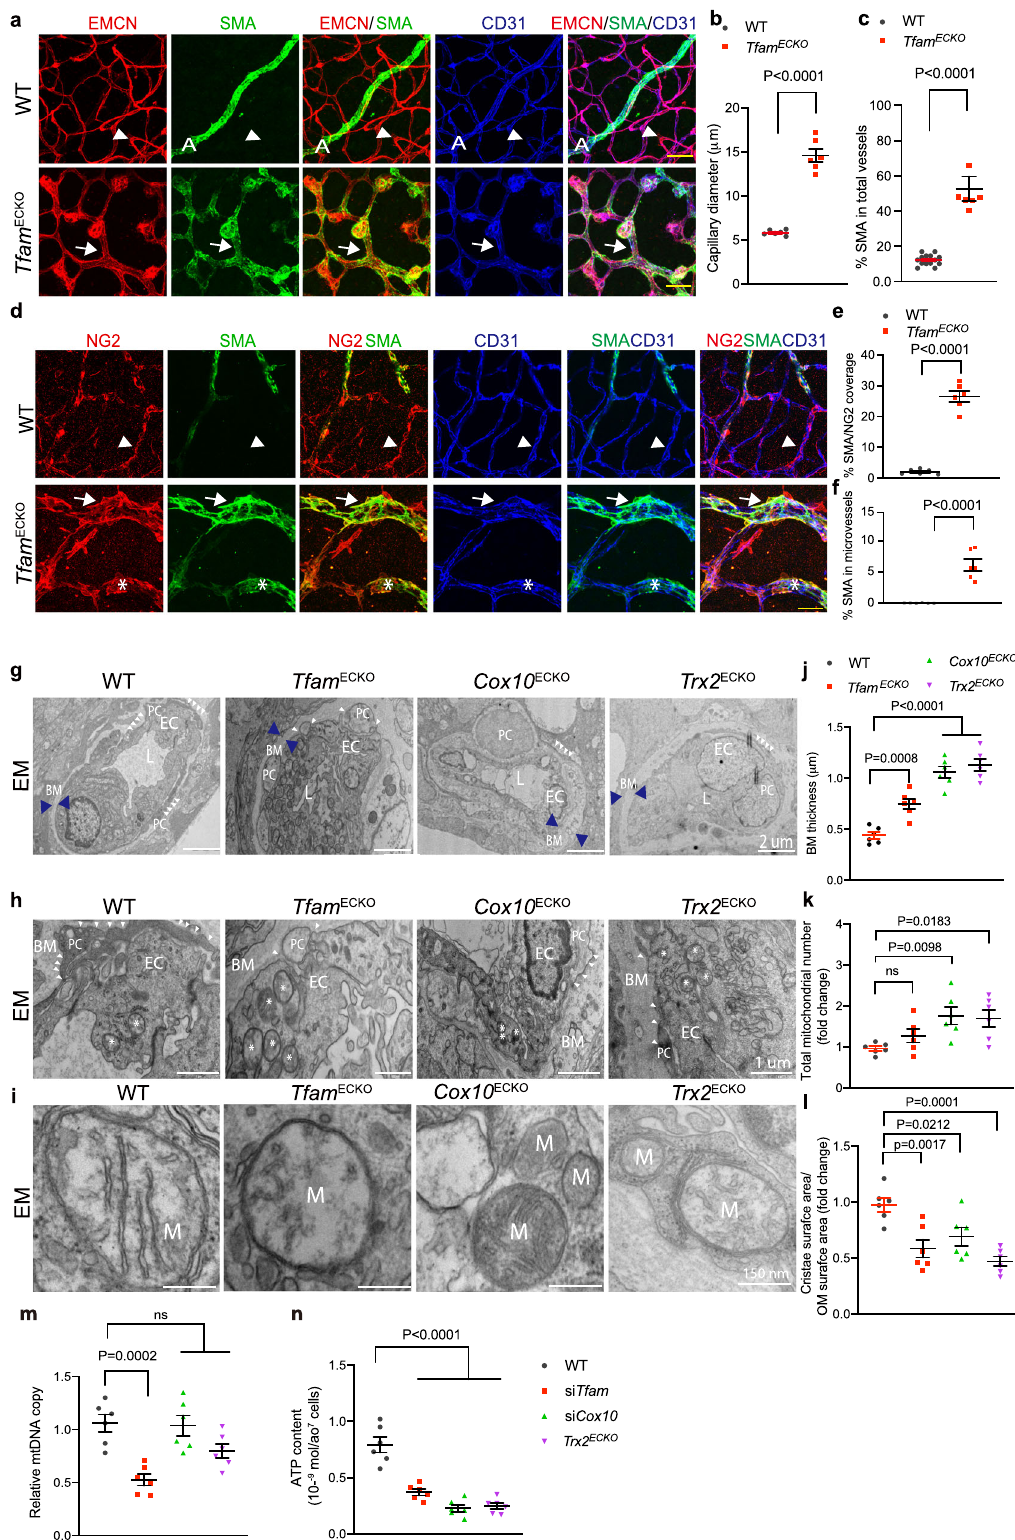
on genetic rescues by the Smad de fi ciency 41 . Smad2 ECKO and tamoxifen. P15 retinaltissues wereexamined forsprouting defects and microaneurysms. Smad2 deletion in retinal ECs was veri fi ed by qRT- PCR and Western blotting by comparing ECs vs non-EC populations